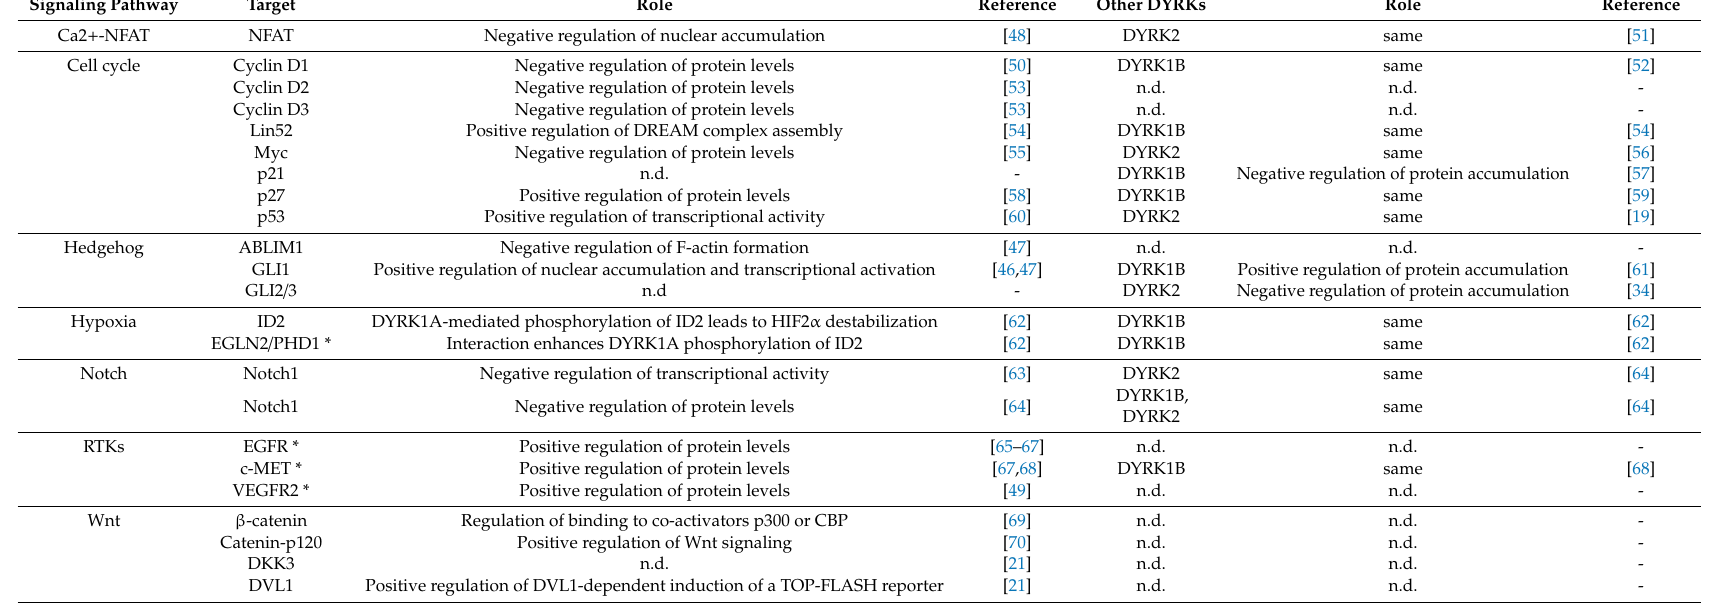
Table 1. Signaling molecules targeted by DYRK1A and other dual-specificity tyrosine-regulated kinases (DYRKs). Signaling